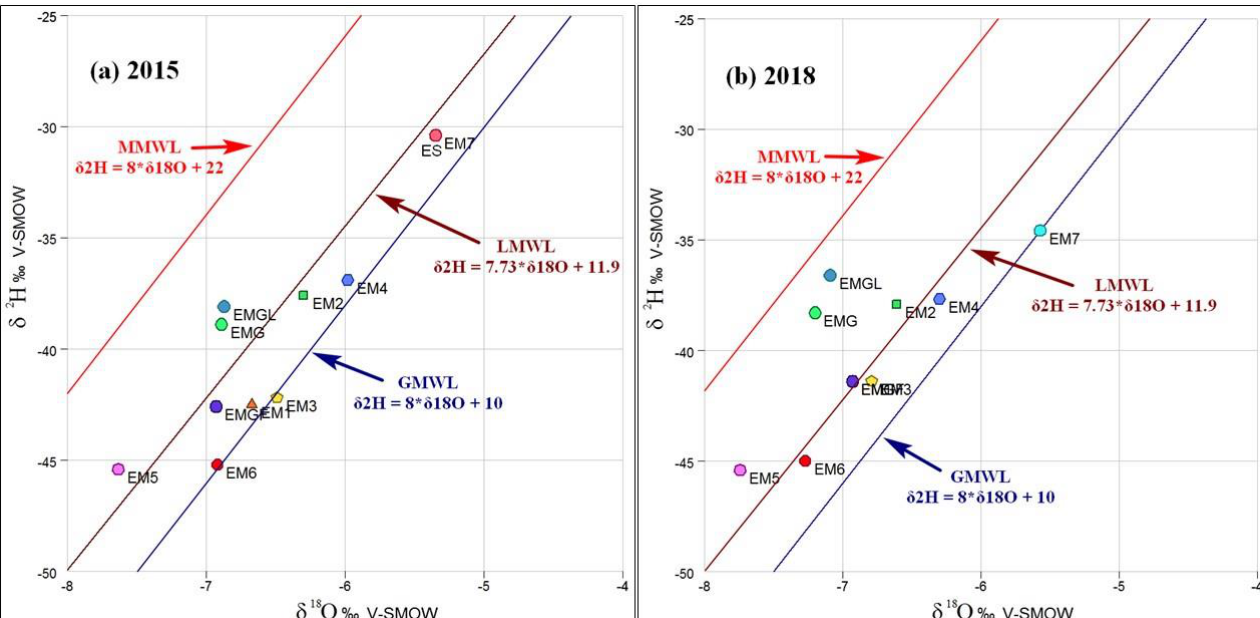
Figure 10. Relationship between δ 2 H and δ 18 O in 2015 and 2018. MMWL: mediterranean meteoric water line; LMWL: local meteoric water line; GMWL: global meteoric water line.